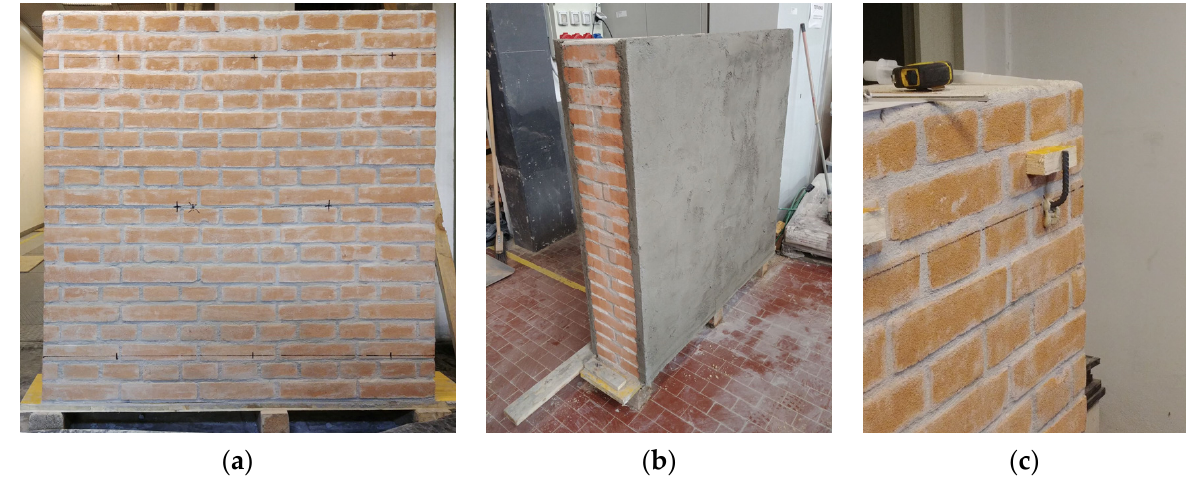
Figure 1. ( a ) Unreinforced masonry specimen; ( b ) retrofitted specimen; ( c ) anchor detail.